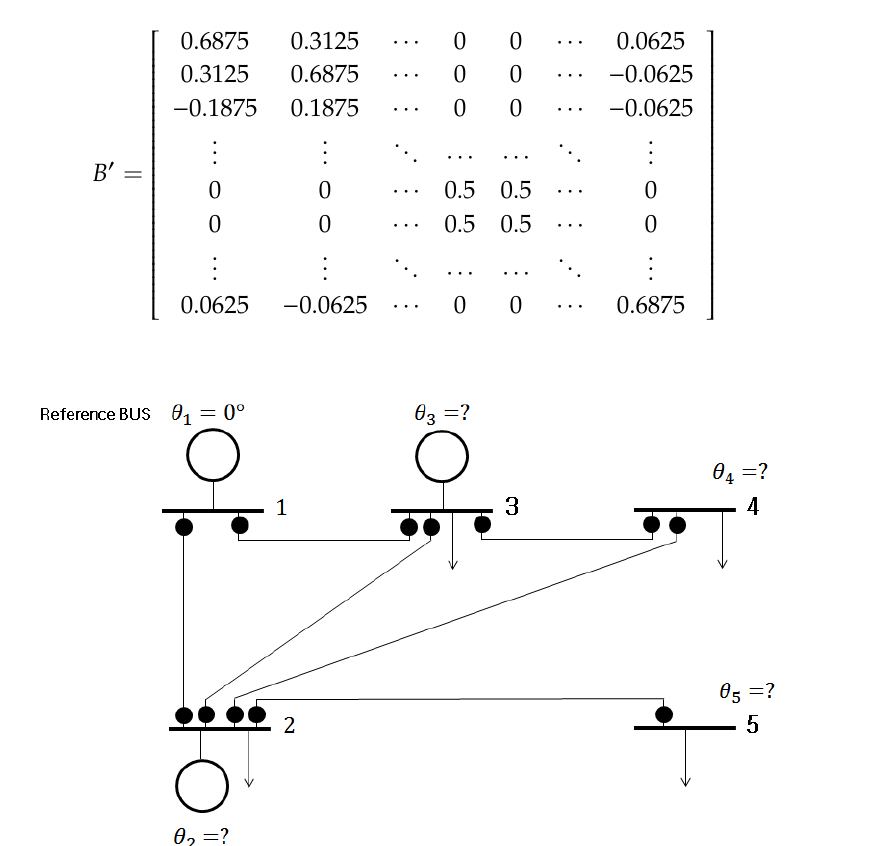
Figure 1. Example 5-bus system.